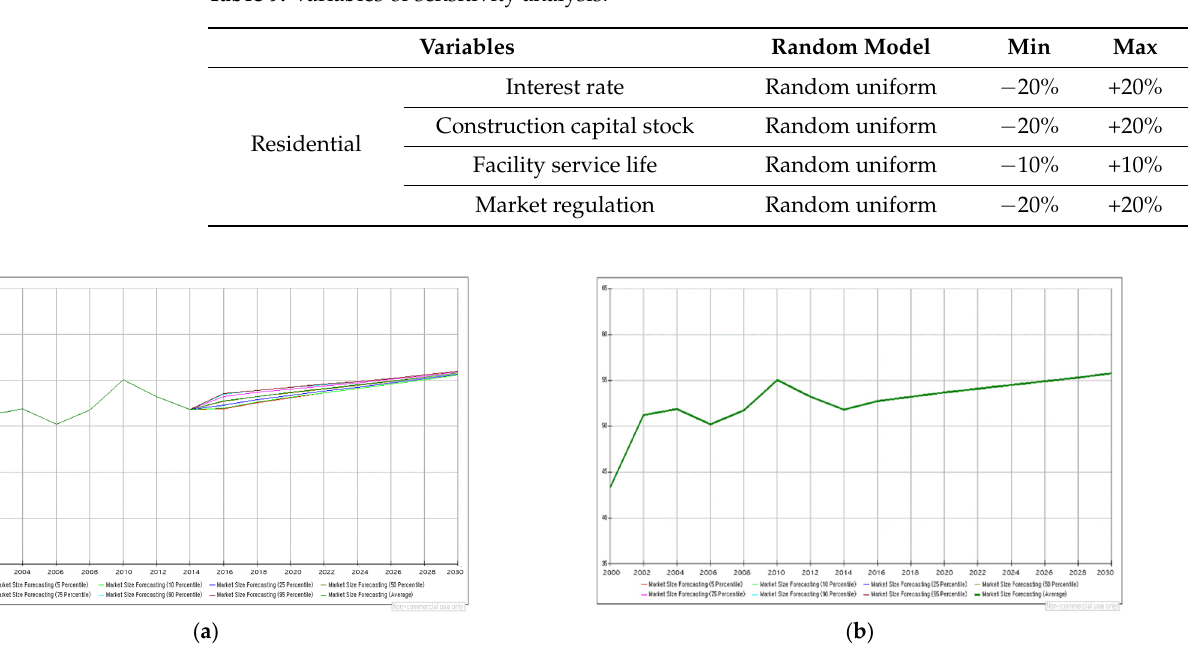
Table 9. Variables of sensitivity analysis.